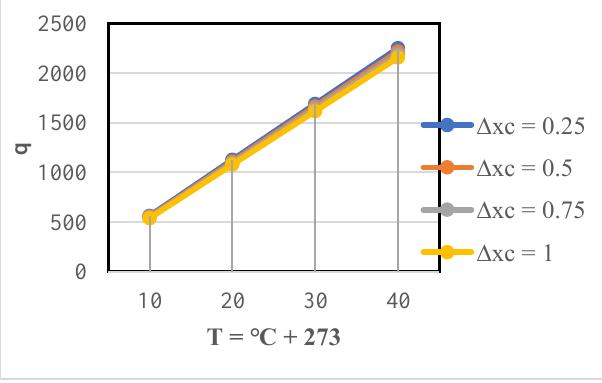
Fig. 3. Graphical presentation between heat flux and temperature at ∆𝑥 = 4 𝜇𝑚 , thickness of copper composite. 𝑎